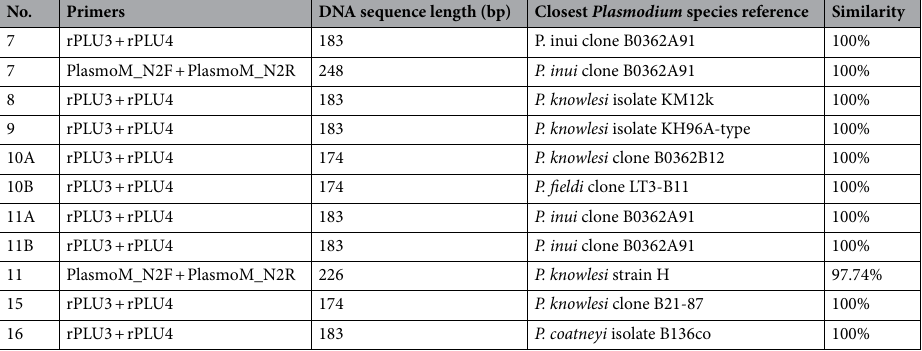
Table 3. Sequencing results for 11 Plasmodium genus positive samples based on the closest reference of Plasmodium species according to the BLAST search analysis of the SSU rRNA gene sequences. Samples from four cases (numbers 6, 12, 13 and 14 in Table 2) were not sequenced because the sequence length was < 100 bp. Samples from cases 7, 10 and 11 were sequenced using different primers or different Nest-1 products, or both.